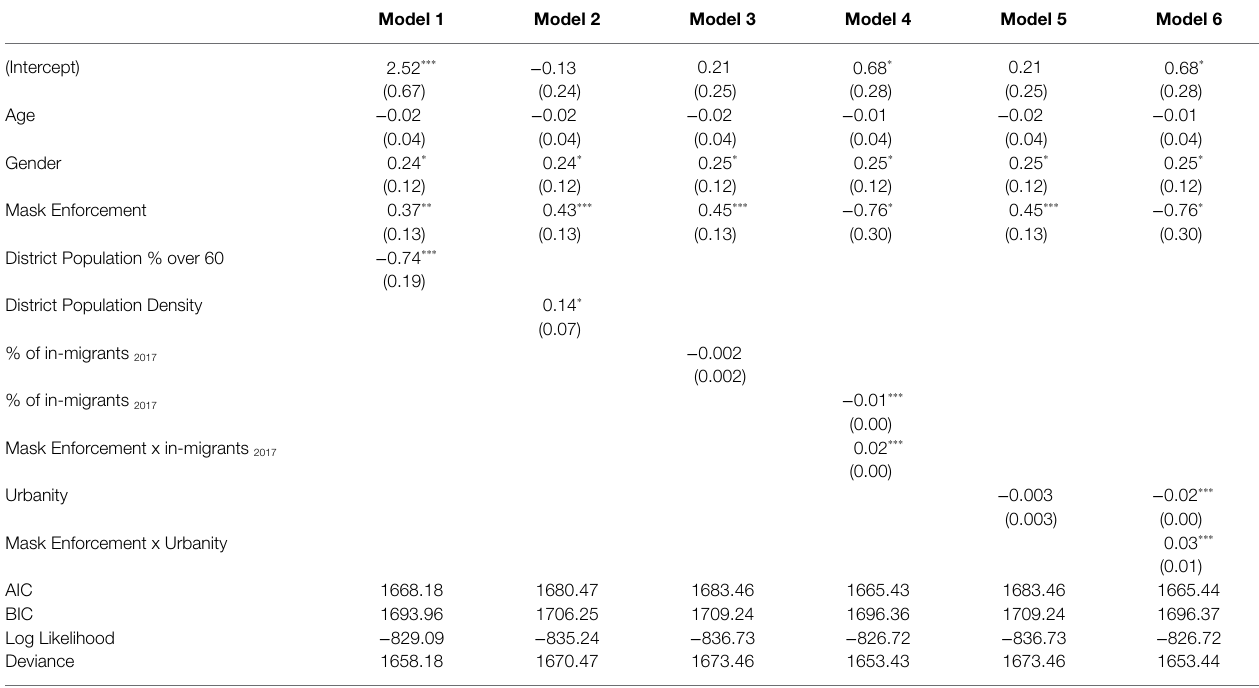
TABLE 2 | District-level factors predict mask usage.